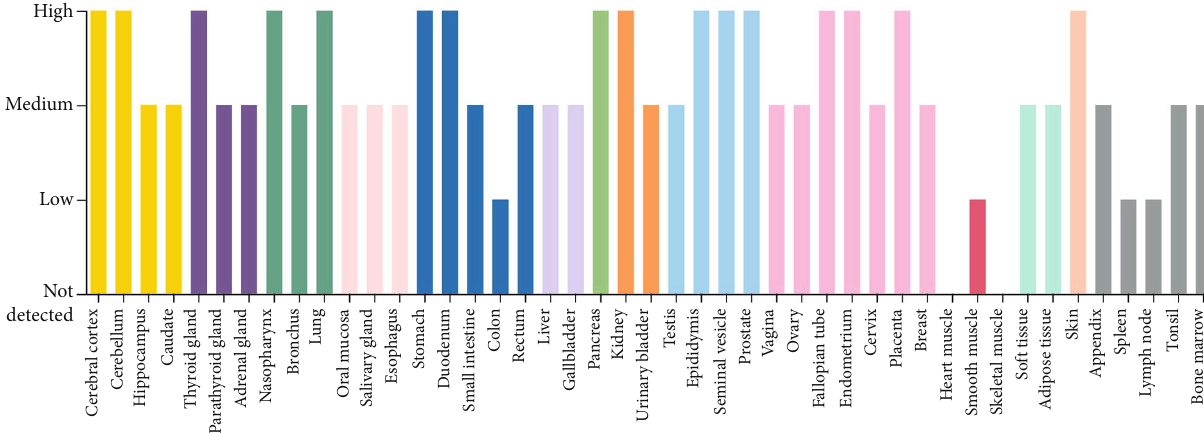
Figure 2: Protein expression levels of PDIA3 in various HPA tumor